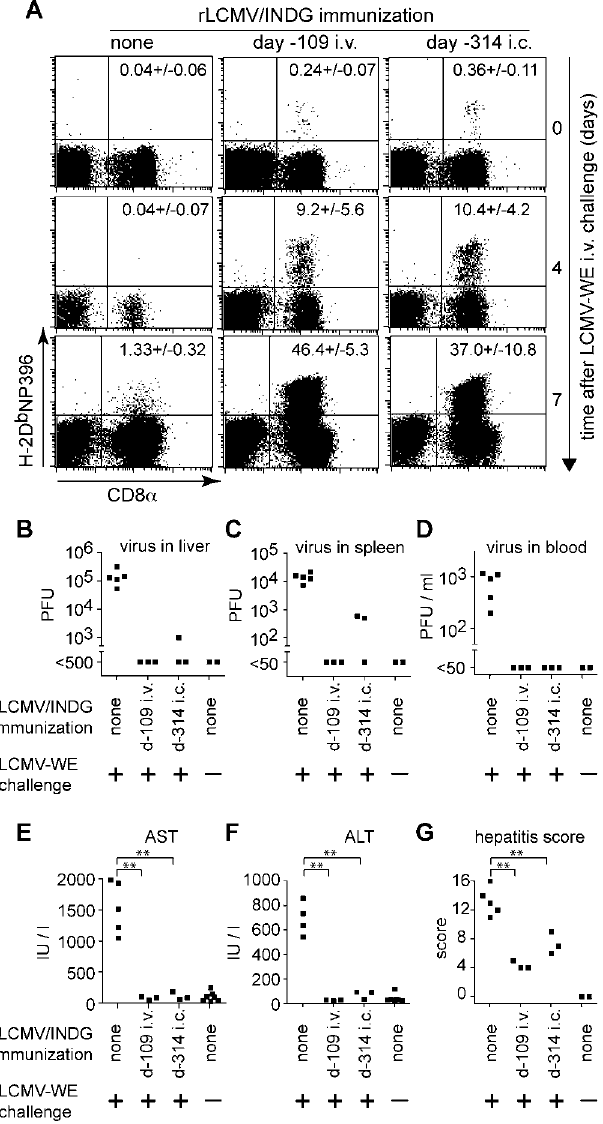
Figure 3. Efficient Control of High-Dose LCMV-WE Infection and Prevention of Liver Disease by rLCMV/INDG-Induced Memory CTL (A) C57BL/6 mice were infected with 2 3 10 4 PFU rLCMV/INDG i.v. or with 3 3 10 3 PFU rLCMV/INDG i.c. on day (cid:1) 109 and on day (cid:1) 314, respectively. On day 0, the immunized mice and a group of naı¨ve control mice ( ‘‘ none ’’ ) were challenged with 2 3 10 5 PFU LCMV-WE i.v. The frequency of NP396-specific memory CD8 þ T cells in peripheral blood was assessed prior to challenge (day 0) and on day 4 and day 7 after challenge using MHC class I tetramers. The numbers in the upper right quadrants indicate the frequency of NP396-specific CD8 þ T cells within the total CD8 þ T cell population in peripheral blood and represent the mean 6 SD of three or four mice per group and time point. (B–D) All mice were killed 7 d after challenge, and viral titers in liver, spleen, and blood were determined by immunofocus assay. (E, F) On day 7, serum AST and ALT levels were determined. (G) Liver sections were scored for hepatitis. The symbols in B–G represent individual mice. Statistical analysis was carried out for E–G. Significant differences between groups are indicated for ** P , 0.01. All findings described were reproduced in the experiment shown in Figure S5. DOI: 10.1371/journal.ppat.0020051.g003